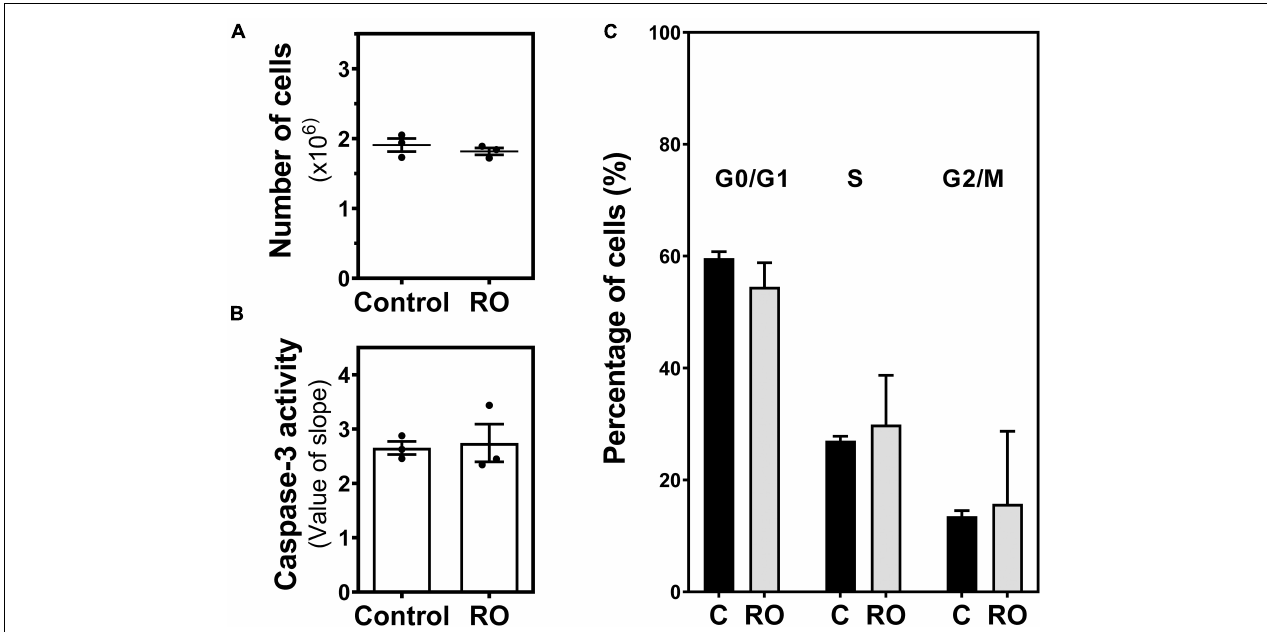
FIGURE 9 | Effect of PDE inhibition on C6 glioma cell growth. Cells were exposed to 100 µ M RO-20-1724 (RO) for 24 h and (A) the number of cells, (B) caspase-3 activity, and (C) cell cycle phases were analyzed and measured as described in “Materials and Methods.” Data are means ± SEM of three independent